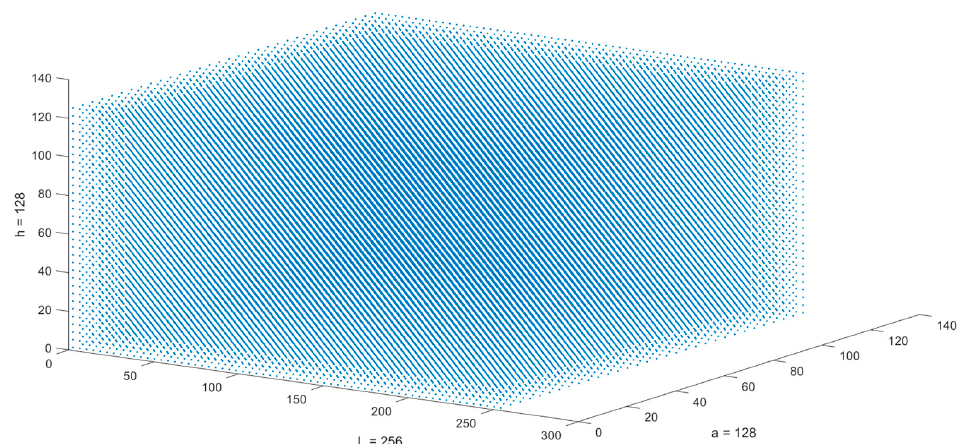
Figure 3. Representation of the original beam. L = 256, h = 128, a = 128 and r = 4.